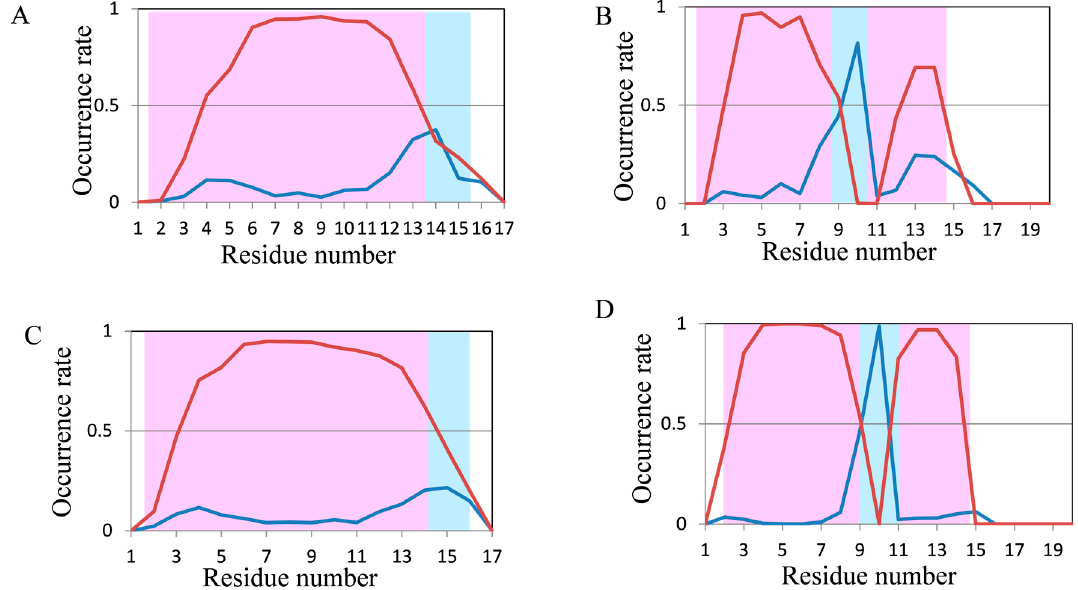
Figure 4. Analysis of the secondary structure formation in 2I9M (17 residues) and Trp-cage (20 residues) using normal MD simulations. The occurrence rate of secondary structures of ( A ) 2I9M; ( B ) Trp-cage using 200-ns simulations and ( C ) 2I9M and ( D ) Trp-cage in 2000-ns simulations. Color coding is the same as Figure 3.